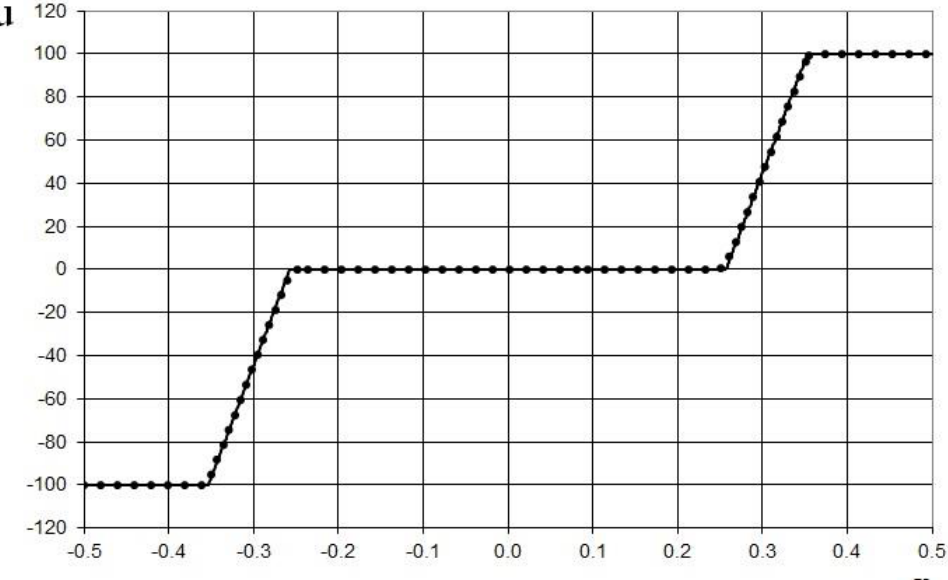
Figure 21. Velocity plot for the double expansion wave problem (47) for the one-dimensional scalar hyperbolic conservation law, using the finer grid (1000 grid points): the exact solution (solid line), and the present method (dotted line).